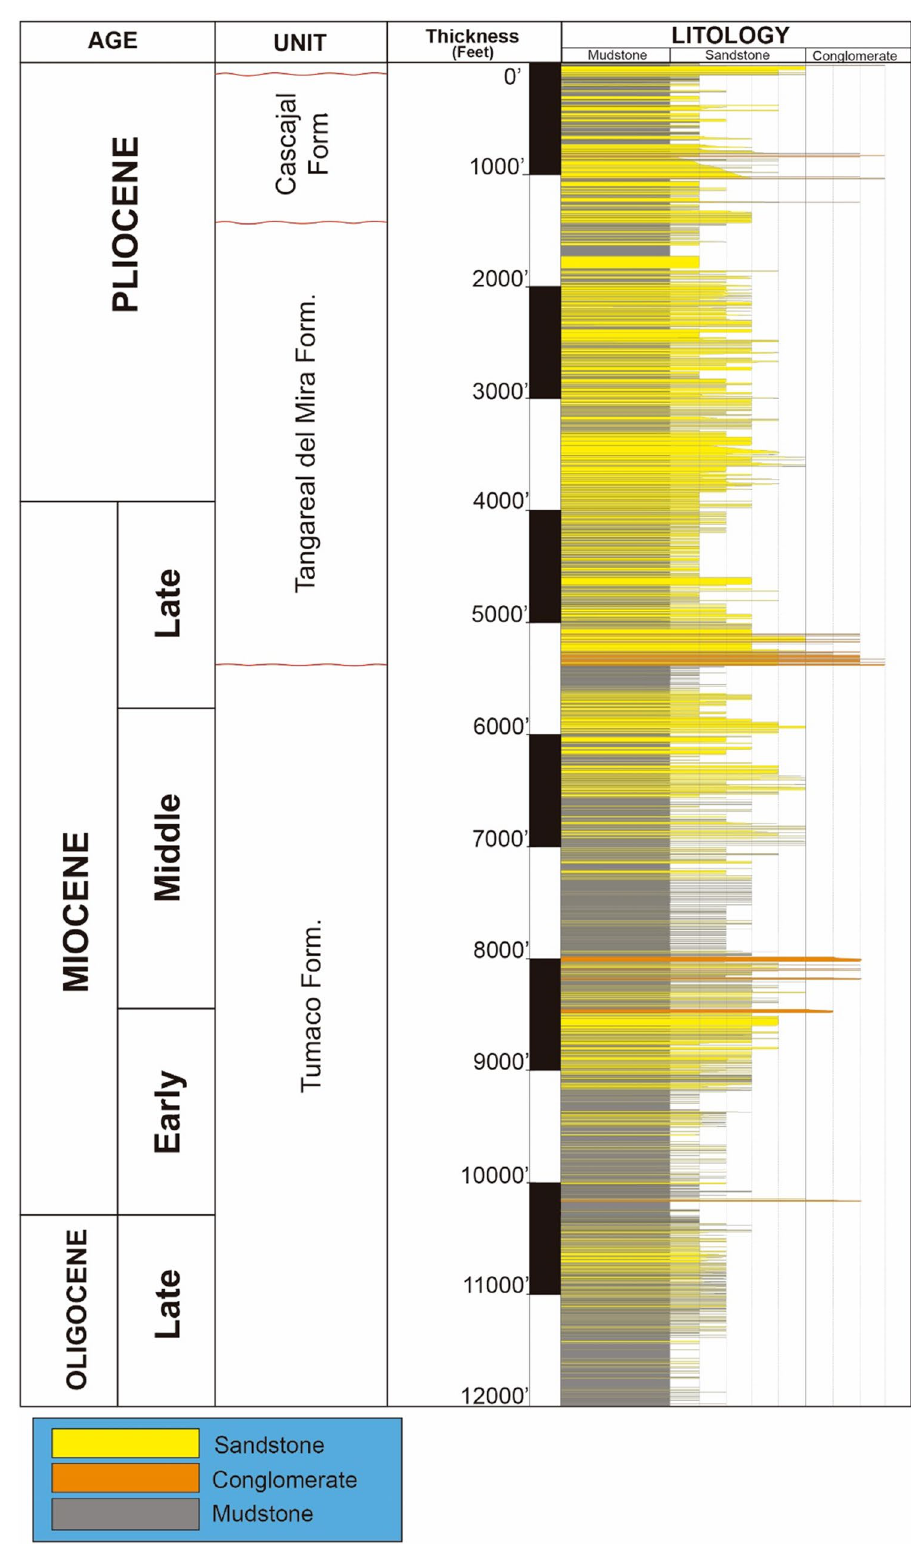
Fig. 2 Generalized lithostrati- graphic column of Tumaco basin (ANH-Antek S.A.